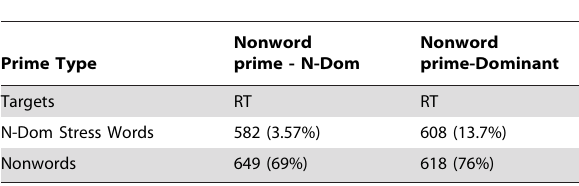
Table 3. Mean correct naming times, percentage of stress errors (in parentheses) for word targets with non-dominant stress, primed by words with non-dominant stress and nonwords with dominant stress in Experiment 1